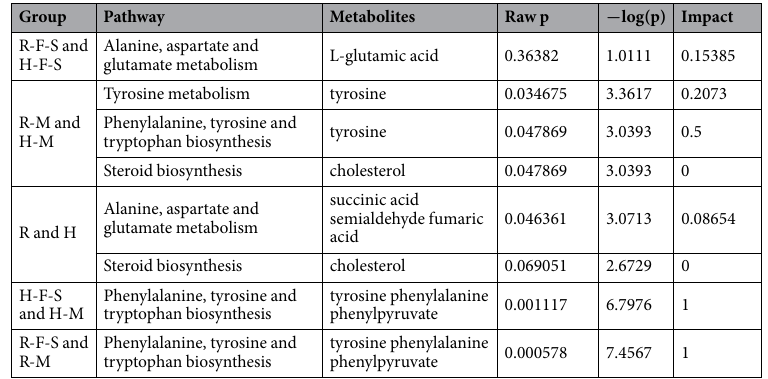
Table 1. Results of further analysis of different metabolite’s pathway in the different groups. Raw p: represents P value of enrichment analysis of metabolic pathway; − log(p): the negative common logarithm of P value; Impact: the Impact value of topology analysis of metabolic pathway.